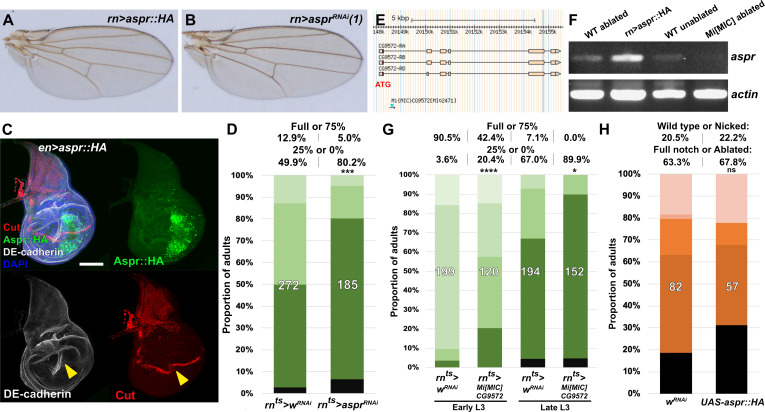
aspr promotes regeneration.(A–B) Adult wings from discs ectopically expressing aspr with rn-GAL4 constitutively driving UAS-aspr::HA (A) or knockdown of aspr using UAS-asprRNAi (B) at 25°C. Wings have no obvious developmental defects, (C) Disc expressing Aspr::HA (green) in the posterior compartment using en-GAL4. DE-cadherin (gray) shows disruption of the pouch tissue due to unusual folding at the expression boundary of Aspr::HA (arrowhead). This fold is further highlighted by the disrupted Cut pattern (red, arrowhead), although levels and timing of Cut expression are otherwise unaffected. Scale bars = 50 μm, (D) Discs ablated with rnts>egr and expressing control wRNAi and asprRNAi, assayed for regeneration by adult wing size as in Smith-Bolton et al., 2009. Graph illustrates the proportion of adults eclosing with the indicated wing phenotypes, with the number of wings scored for each condition shown. The percentage of wings scored as ‘full or 75%’ and ‘25% or 0%’ is labeled above. Knockdown of aspr using UAS-asprRNAi leads to a reduction in regenerated wing size, *** p = 0.0008, Fisher exact test, (E) Genome browser screenshot (www.Flybase.org) showing position and orientation of the Mi[MIC]CG9572 transposon insertion within the first intron (after the coding start site) of aspr. The GFP on the transposon acts as an enhancer trap for activity of aspr, while the intronic position likely prematurely terminates aspr transcription, (F) Semi-quantitative PCR of rnts>egr ablated discs from MiMIC hemizygous animals (Mi[MIC]CG9572[MI02471]/Y) show strongly reduced levels of aspr mRNA compared to ablated wild type (WT) discs, consistent with this line being a transcriptional mutant. Levels of mRNA in discs ectopically expressing aspr using rn-GAL4 (rn >aspr::HA) and in unablated wild type discs are shown as controls. Level of actin mRNA is shown as a amplification control for each sample, (G) Wing regeneration assay as in (D) using rnts>egr, comparing regeneration in male control flies versus hemizygous males with the Mi[MIC]CG9572 insertion. The Mi[MIC] line has strongly reduced ability to regrow wing tissue compared to the control at two different developmental time points, **** p <0.0001, * p = 0.032, Fisher exact test, (H) Discs ablated with rpr using DUAL Control and expressing UAS-aspr::HA using DVE>>GAL4, assayed for regeneration by adult wing size and compared to the standard control wRNAi. Graph illustrates the proportion of adults eclosing with the indicated wing phenotypes, with the number of wings scored for each condition shown. The percentage of wings scored as ‘wild type or nicked’ and ‘full notched or ablated’ is labeled above. Overexpression of aspr::HA does not strongly affect regeneration. ns: not significant, Fisher exact test.